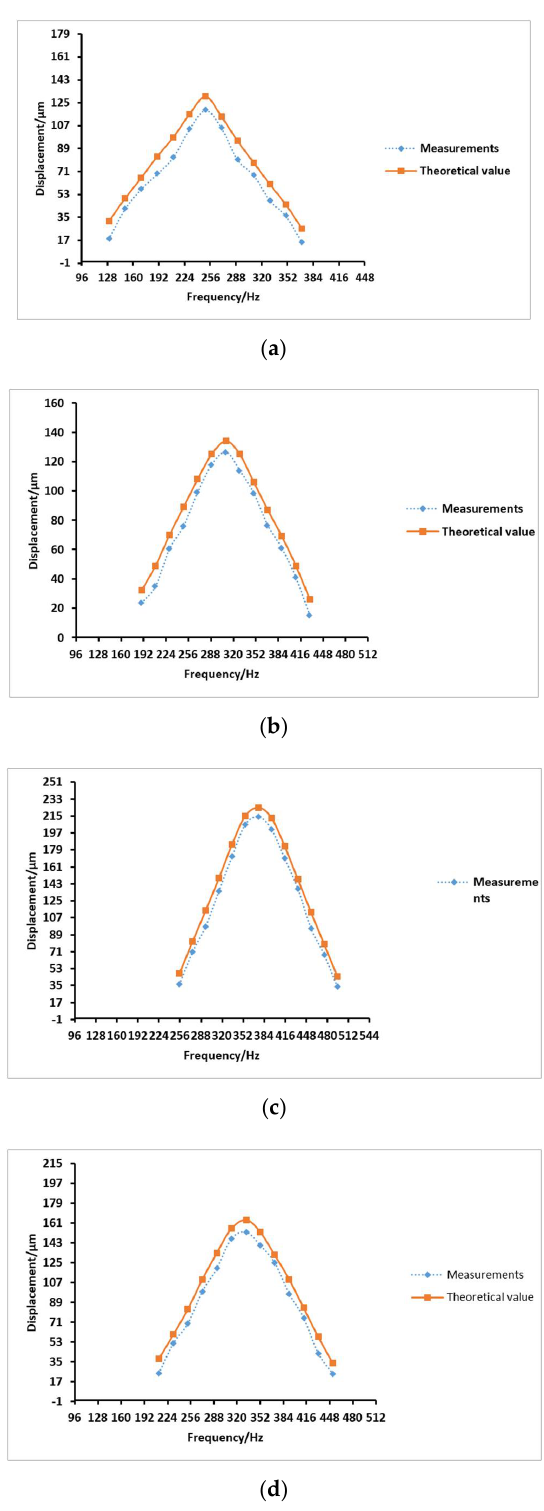
Figure 8. Curve of driving frequency versus displacement of the flexible membrane of the four sets of prototypes. ( a ) The driving frequency and displacement curve of flexible membrane of prototype 1; ( b ) the driving frequency and displacement curve of flexible membrane of prototype 2; ( c ) the driving frequency and displacement curve of flexible membrane of prototype 3; ( d ) the driving frequency and displacement curve of flexible membrane of prototype